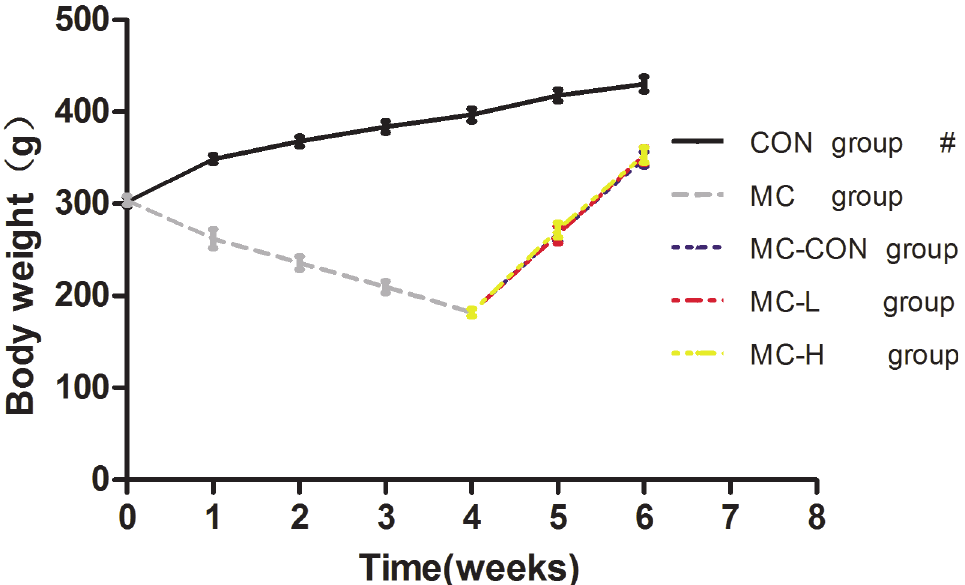
Fig 1. Body Weight of the Rats. Values are presented as means ± standard deviation (SD). # indicates a significant difference, p < 0.01.